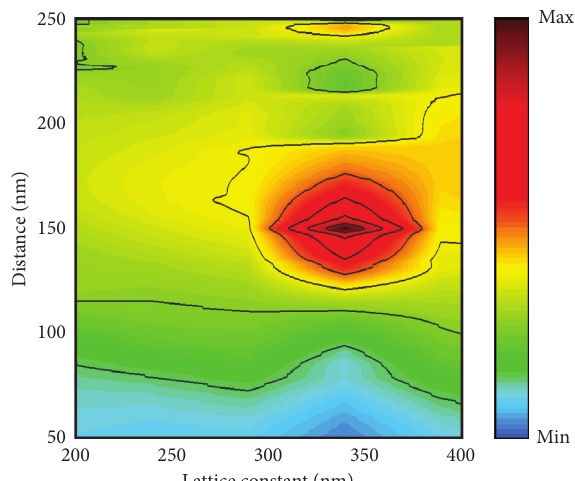
Figure 15: Integrated absorption efficiency (AE the angle of incidence ( θ ) for TM and TE biases.